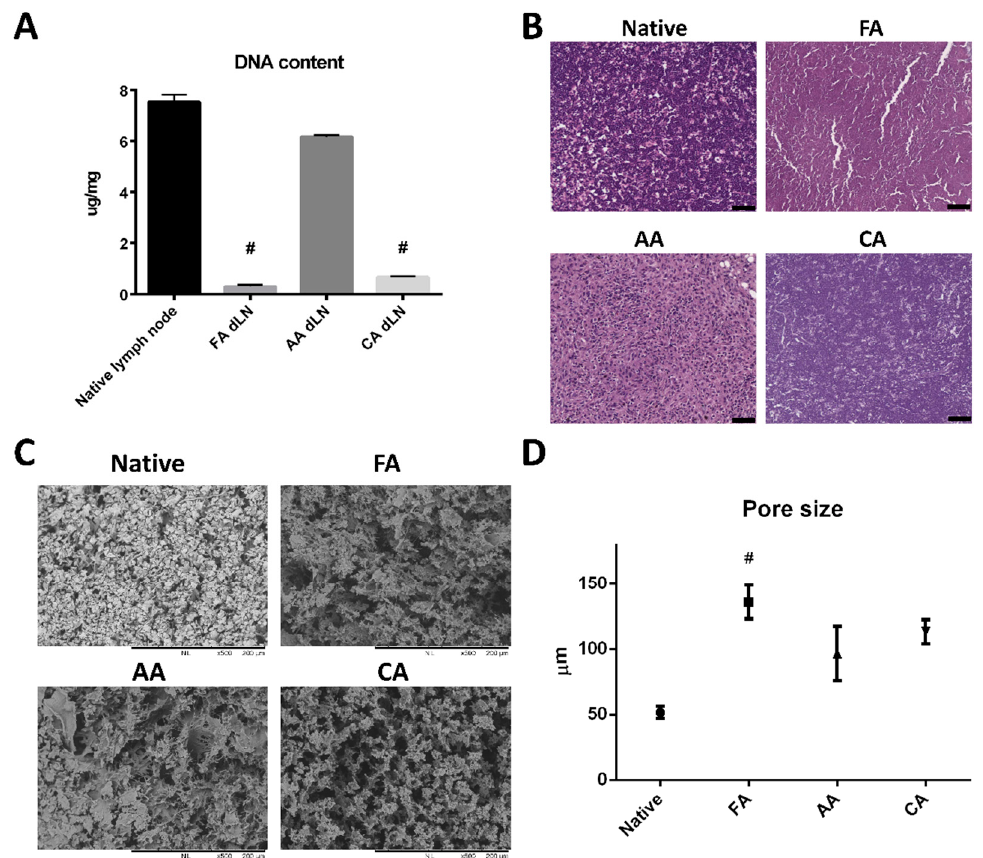
Figure 1. Efficacy of the organic acid decellularization process of decellularized lymph node (dLN). ( A ) Quantification of residual DNA from native lymph nodes and dLN. (Data are presented as the mean ± SD, #: p < 0.001.) ( B ) hematoxylin and eosin (HE) staining of lymph node scaffolds: native lymph node and lymph node treated with formic acid (FA) 30%, acetic acid (AA) 30%, and citric acid (CA) 30%. (Scale bar: 50 µm). ( C ) Microstructure of the decellularized lymph node (dLN) scaffolds. Scanning electron microscope images show the microstructures of a native lymph node and a lymph node treated with formic acid 30%, acetic acid 30%, and citric acid 30%. ( D ) Average pore sizes of the native lymph node and dLN scaffolds. (Data are presented as the mean ± SD, #: p < 0.001.).